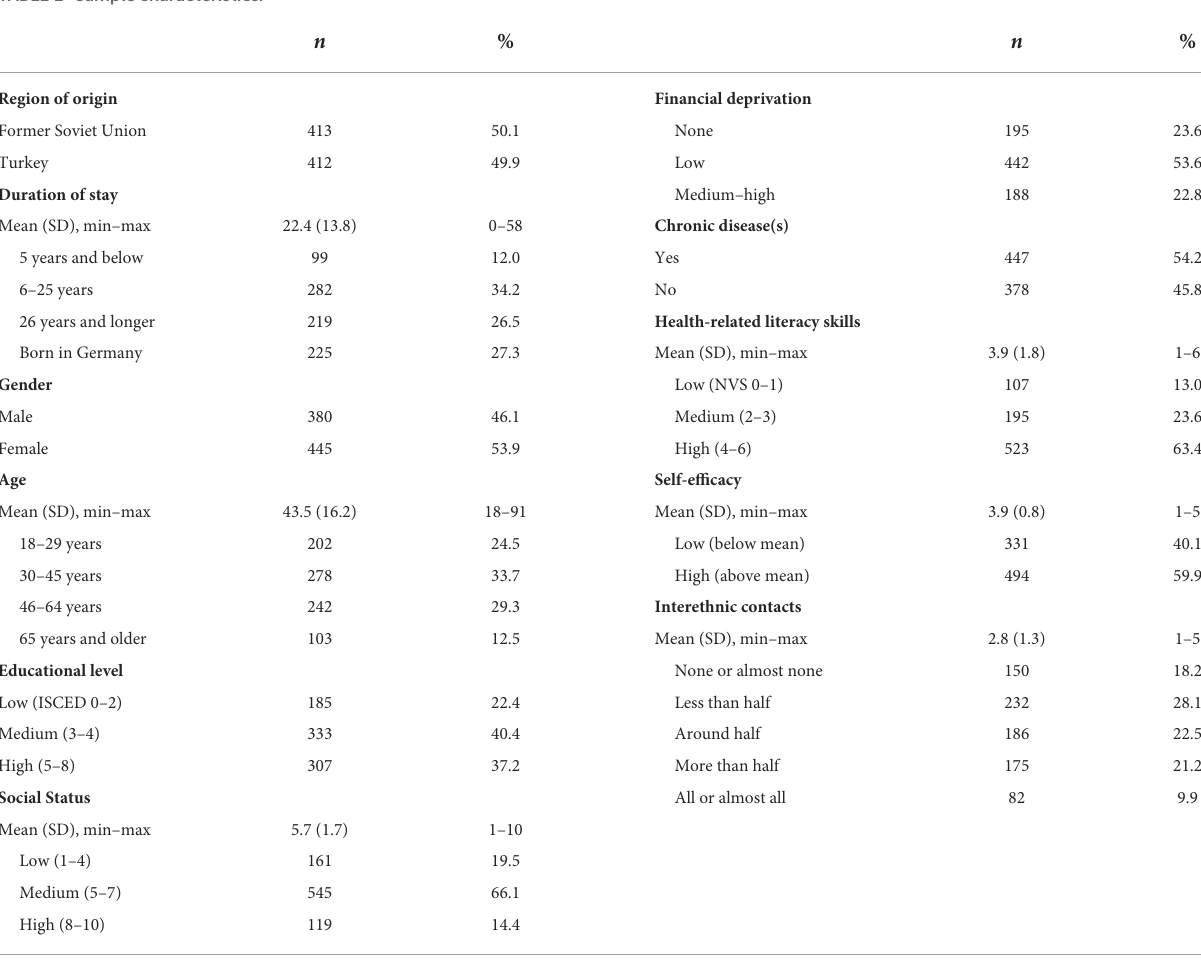
TABLE 1 Sample characteristics.